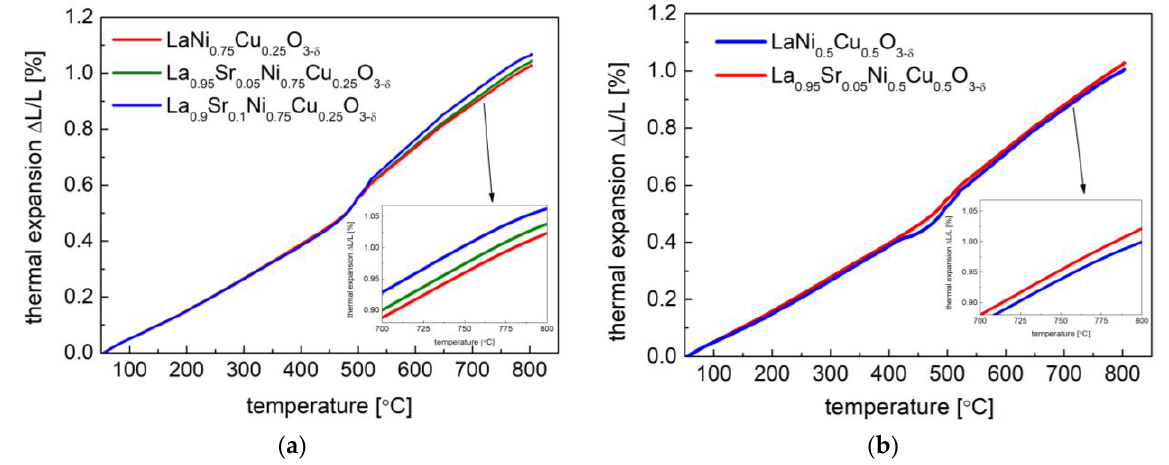
Figure 7. Thermal expansion behavior of ( a ) La 1−x Sr x Ni 0.75 Cu 0.25 O 3−δ (x = 0, 0.05 and 0.1) samples; ( b ) La 1−x Sr x Ni 0.5 Cu 0.5 O 3−δ (x = 0 and 0.05) sinters by dilatometry measurements.